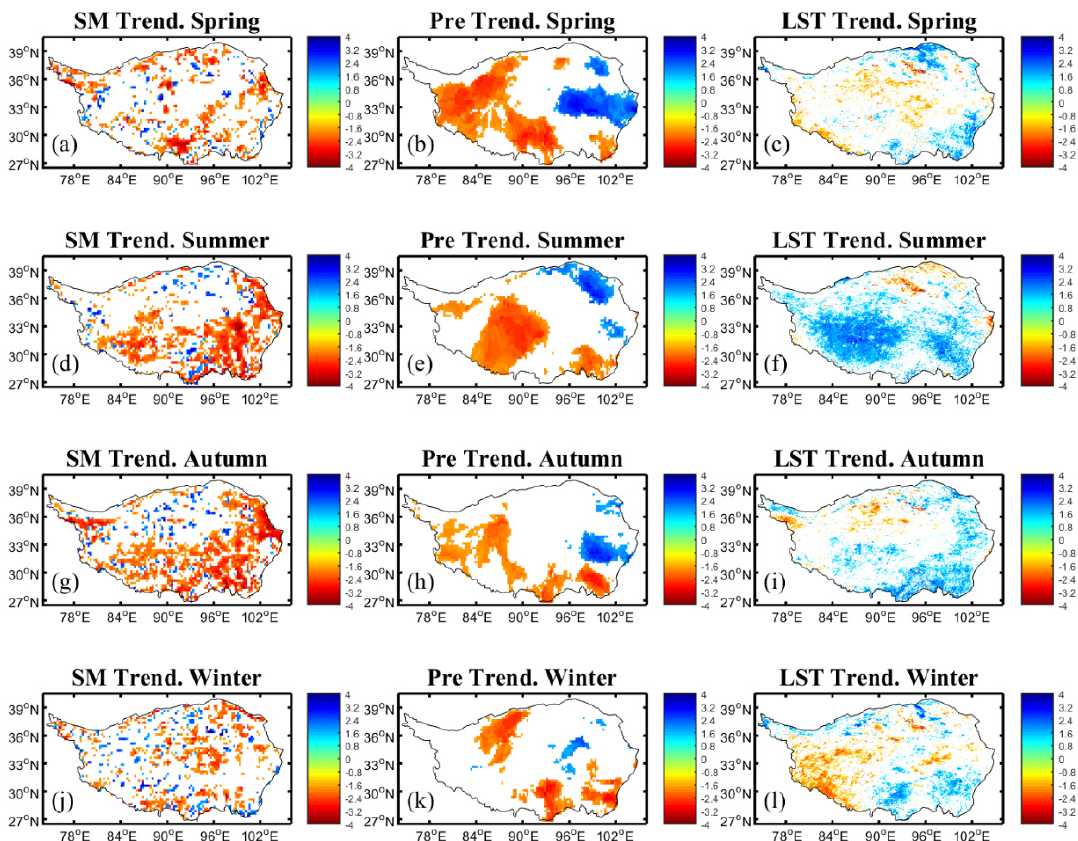
Figure 13. Seasonal trend of SM, precipitation and land surface temperature (LST) from 2002 to 2015 with a significance level of α = 0.05: ( a , d , g , j ) are seasonal trends of SM in spring, summer, autumn and winter respectively; ( b , e , h , k ) are seasonal trends of precipitation in spring, summer, autumn and winter respectively; ( c , f , i , l ) are seasonal trends of LST in spring, summer, autumn and winter respectively.